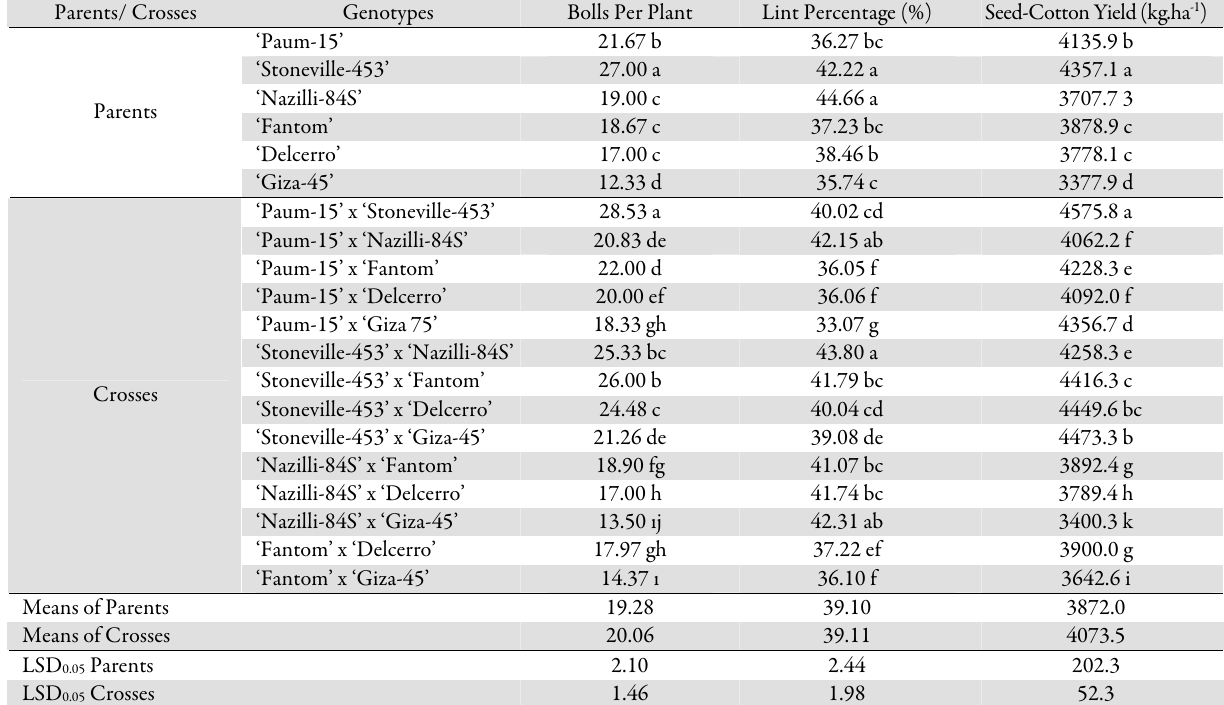
Table 2. The means of investigated traits of the 6 parental genotypes and the 15 F 1 diallel crosses Parents/